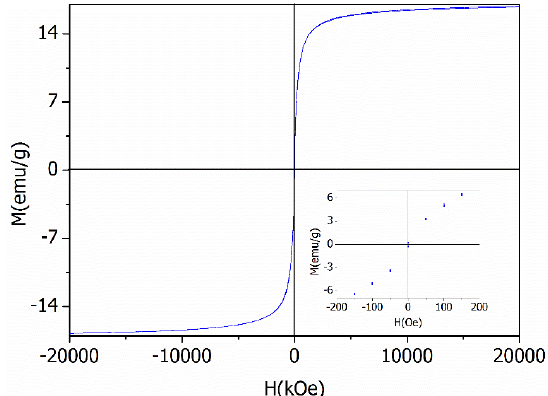
Figure 3. Magnetization (M-H) curves for BiOCl-HAP SM .